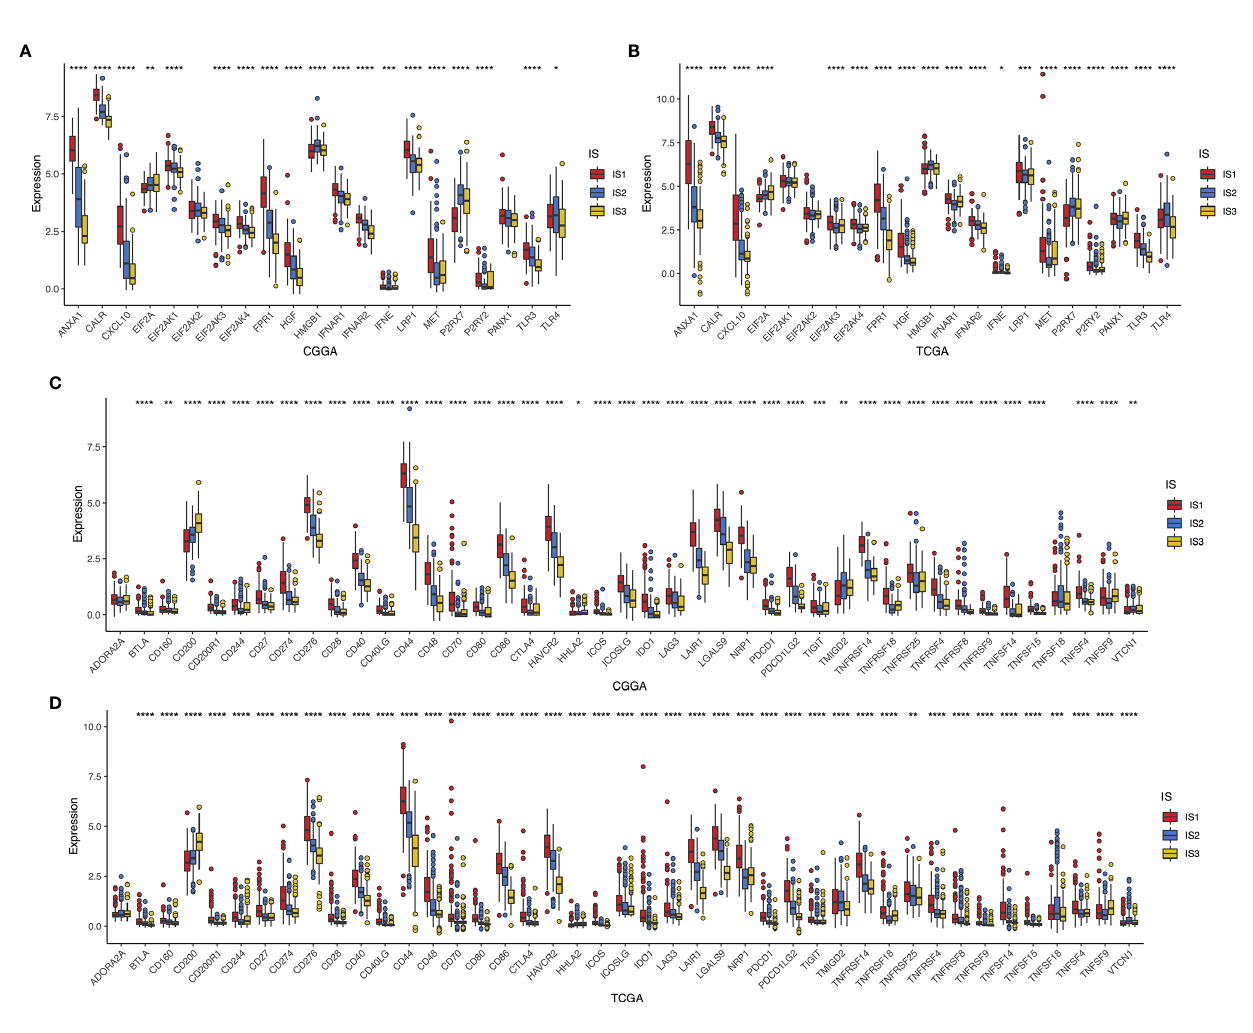
FIGURE 6 | Association between immune subtypes and ICPs and ICD modulators. Differential expression of ICD modulator genes among the glioma immune subtypes in CGGA (A) and TCGA (B) cohorts. Differential expression of ICP genes among the glioma immune subtypes in CGGA (C) and TCGA (D) cohorts. *p < 0.05, **p < 0.01, ***p < 0.001, and ****p <